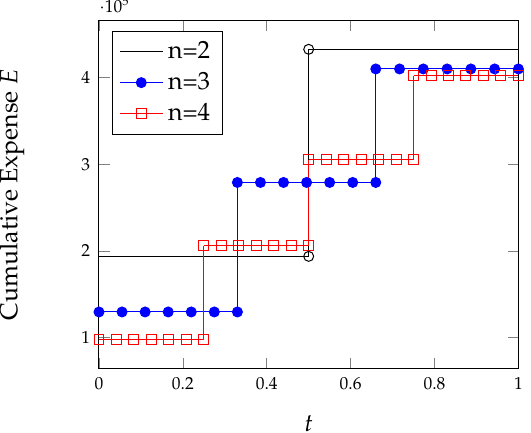
Figure 8. Optimal cumulative investment under full liability and GL2 model.